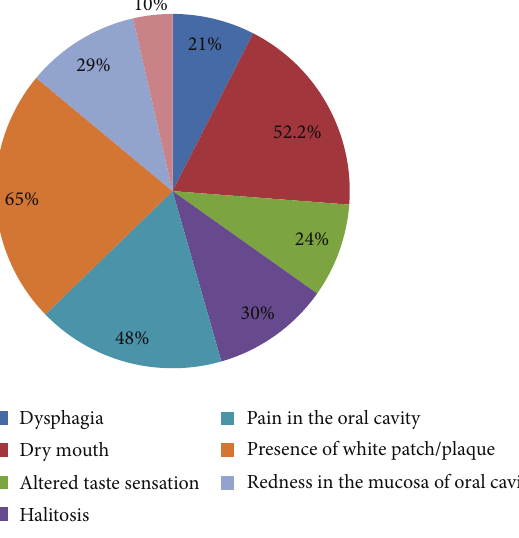
Figure 1: Distribution of symptoms and signs among the cancer patients.